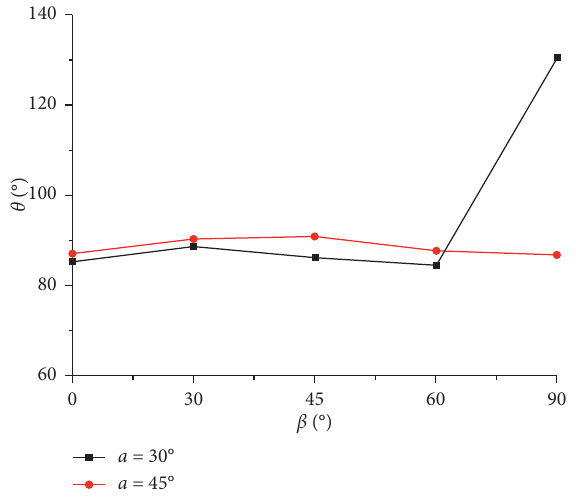
Figure 7: Variations of crack initiation angles with β . the black segment. The thick black line with an arrowhead